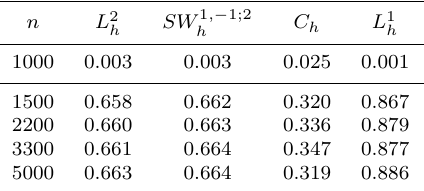
Table 7. Practical errors and error orders in Example A 1 n L 2